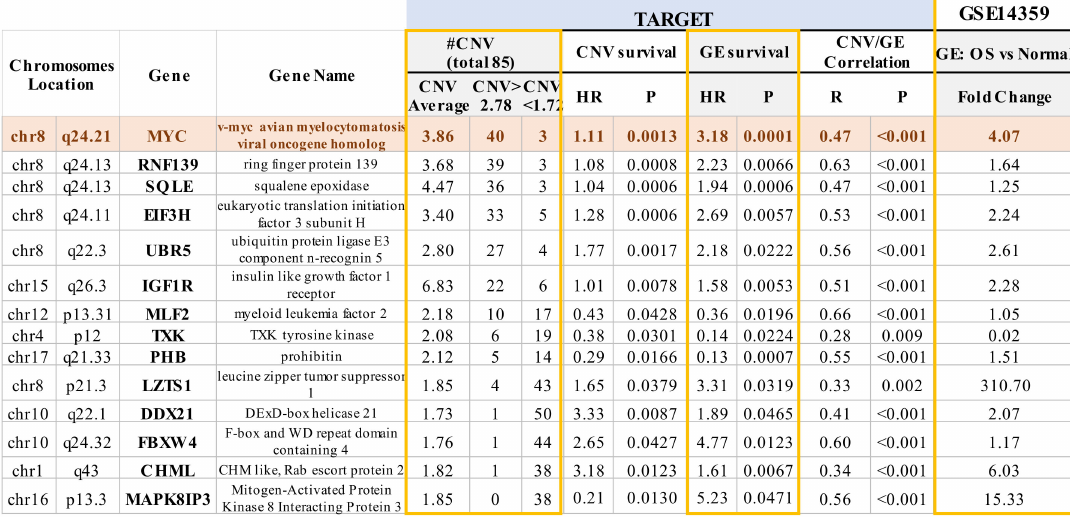
Figure 2. Significant correlations between copy number variation (CNV) and OS patient survival, gene expression and OS patient survival, and CNV and gene expression were evident in 14 genes. The expression of these 14 genes across various chromosomes from TARGET was also compared to non-neoplastic primary osteoblasts from GSE14359. CNVs in 14 genes are associated with the overall survival of OS based on TARGET and GSE16091 datasets. HR > 1 between overall survival and gene expression or CNVs was observed in 10 out of 14 genes, suggesting that copy number gain or increased gene expression results in an increased risk for poor overall survival. CNVs > 2.78 indicates copy number gain, whereas CNVs < 1.72 suggests loss / deletion. HR < 1 between overall survival and gene expression or CNVs was observed in 4 out of 14 genes, suggesting that copy number deletion or decreased gene expression results in an increased risk for poor overall survival. Notably, HR = 1 means that neither gene expression nor CNVs have an e ff ect on the overall survival of OS patients. GE, gene